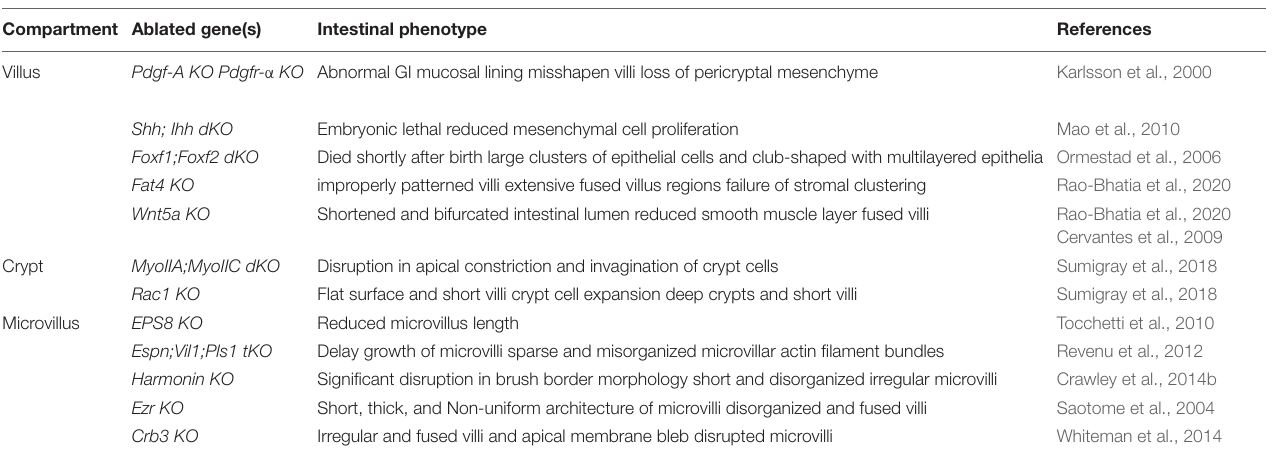
TABLE 1 | Summary of gene list related to morphological abnormalities in crypt-villus structure. Compartment Ablated